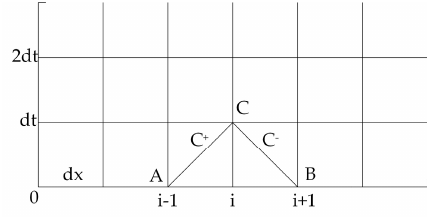
Figure 1. Characteristic lines x-t mesh.